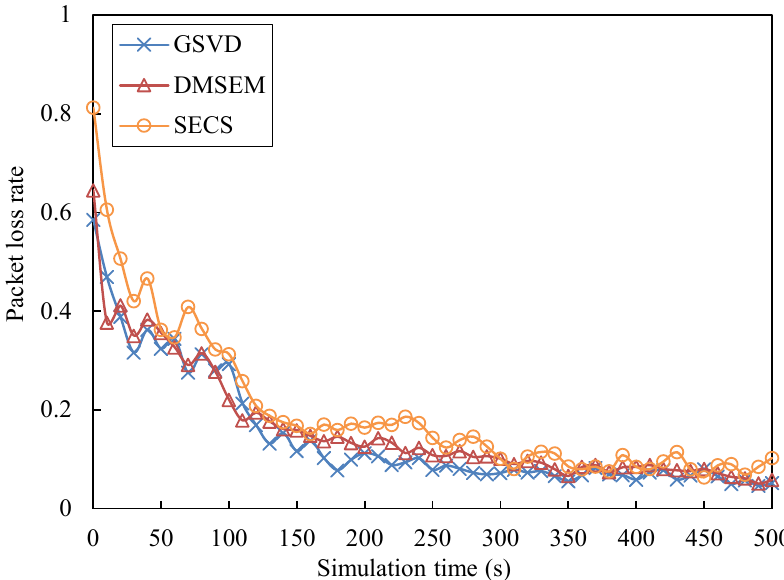
Figure 7. Packet loss rate against the simulation time.